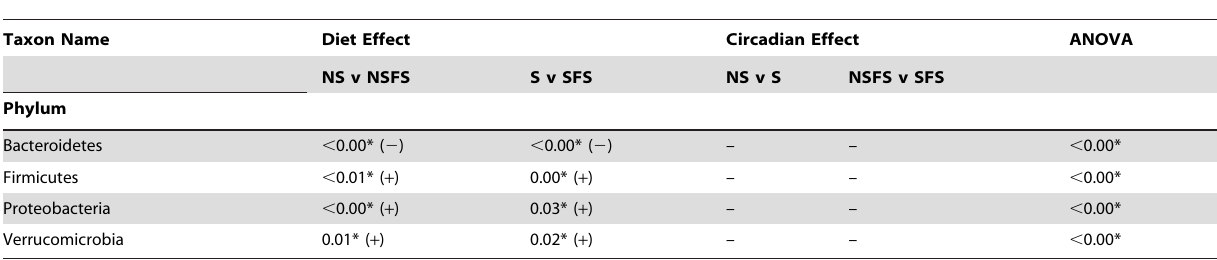
Table 1. Significant between group comparisons by taxon level.